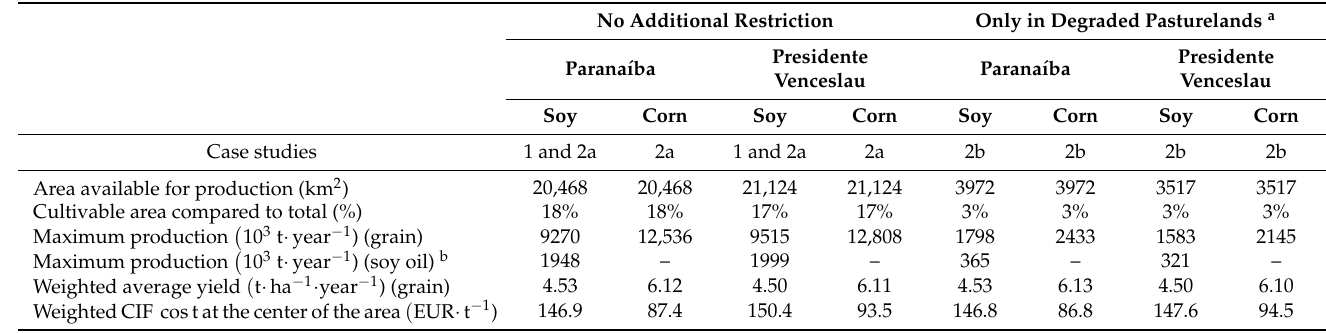
Table 4. Summary of results for the two processing poles regarding soybean and corn production. No Additional Restriction Only in Degraded Pasturelands